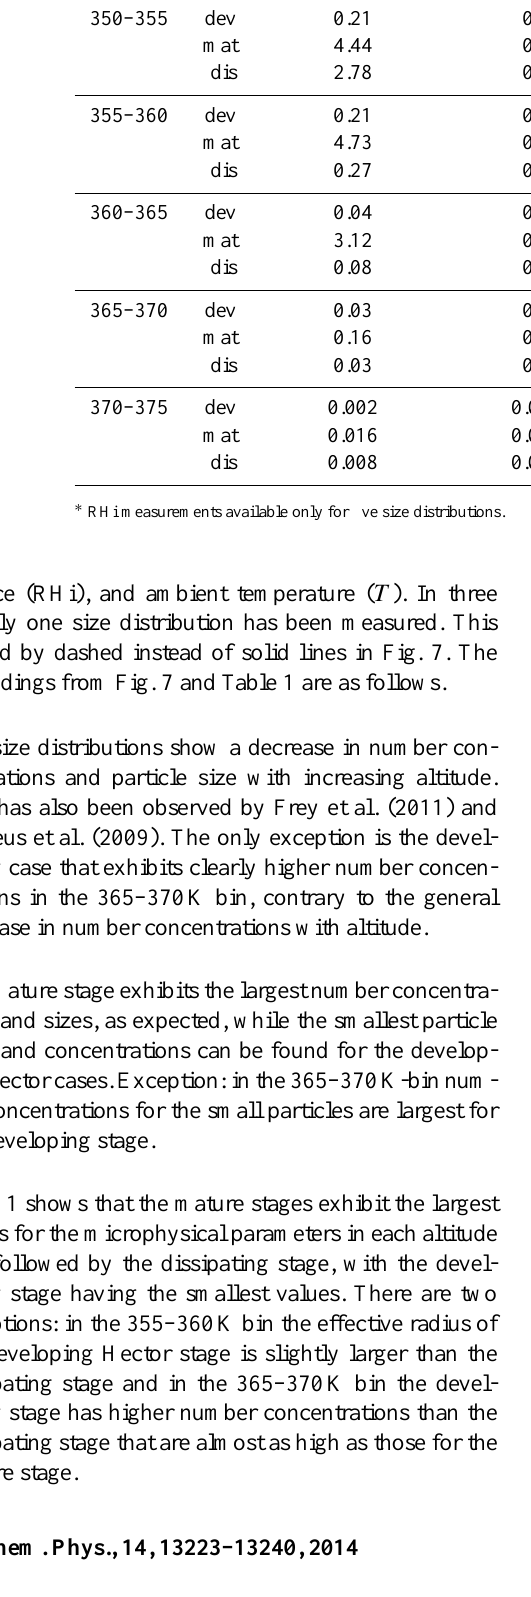
Table 1. Averages of microphysical and meteorological properties for the different Hector stages and altitude bins as in Fig. 7: ice water content (IWC), cloud particle number concentration ( N ), effective radius ( r eff ), relative humidity with respect to ice (RHi), and ambient temperature ( T ). The last column indicates the number of size distributions for each class. T pot [K]